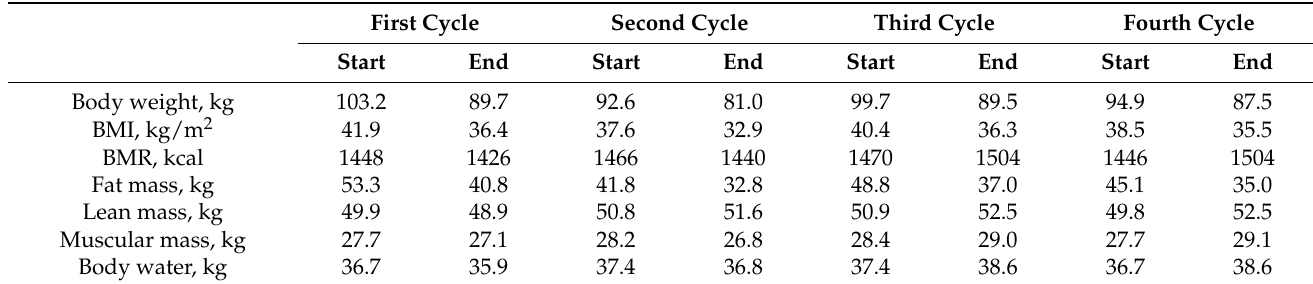
Table 2. Bioelectrical impedance parameters during diet